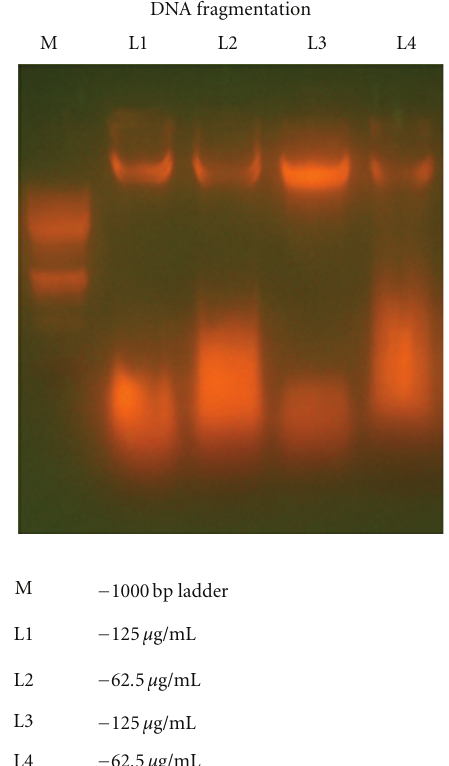
Figure 4: The DNA fragmentation analysis of oligonuceosomal- sized fragments in the MCF-7 cells treated with red sorghum bran